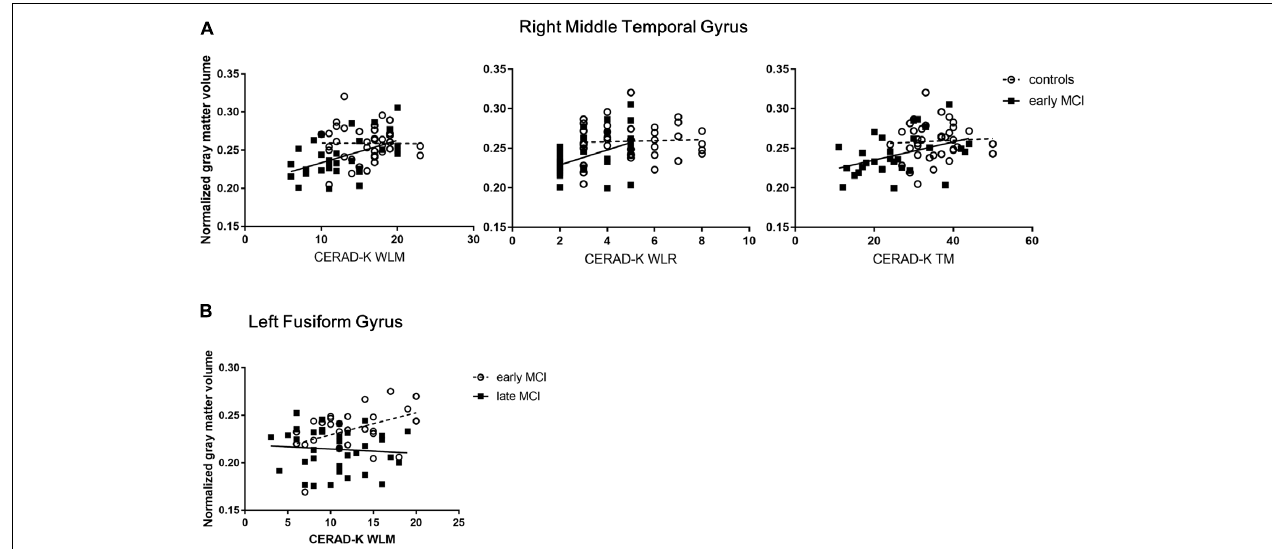
FIGURE 2 | (A) Significant group (healthy control vs. early MCI) by memory performance interactions for normalized gray matter volumes of the right middle temporal gyrus (RMTG). (B) Significant group (early MCI vs. late MCI) by memory performance interactions for normalized gray matter volumes of the left fusiform